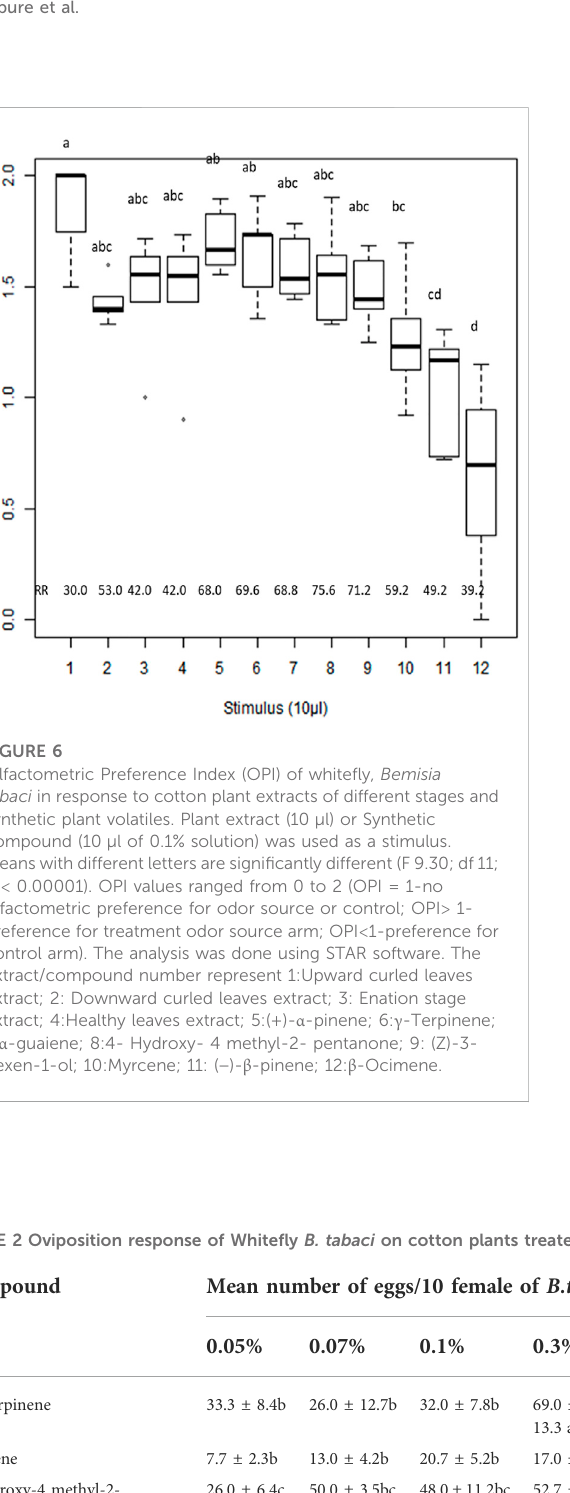
TABLE 2 Oviposition response of White fl y B. tabaci on cotton plants treated with synthetic volatile organic compounds (VOC ’ s). Compound Mean number of eggs/10 female of B.tabaci